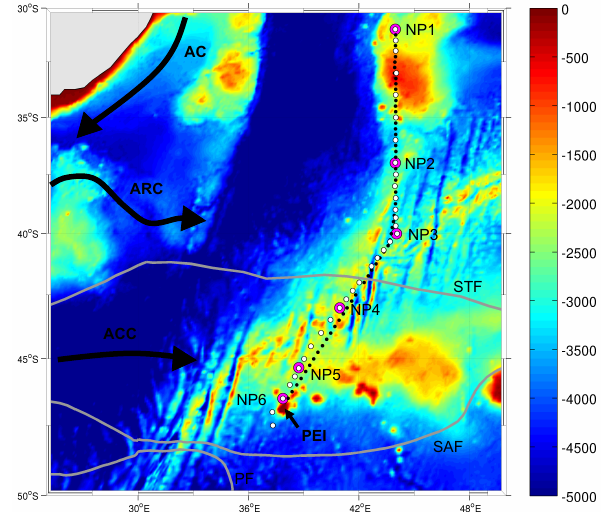
Fig. 1. Cruise tracks overlaid on bathymetry of the Northbound transect, showing XBT station positions as black dots. Together with the reciprocal Southbound transect, showing CTD station po- sitions as white circles. The cruise tracks followed the Southwest Indian and Madagascar Ridge, between the Prince Edward Islands (PEI) and 31 ◦ S. Productivity stations are shown as pink circles and labelled (NP1–NP6). Black arrows mark the position of the Agulhas current (AC), the Agulhas Return Current (ARC) and the Antarctic Circumpolar current (ACC). Grey lines indicate the mean frontal positions of the Sub Tropical Front (STF), the Sub Antarctic Front (SAF) and the Polar Front (PF) according to Orsi et al.